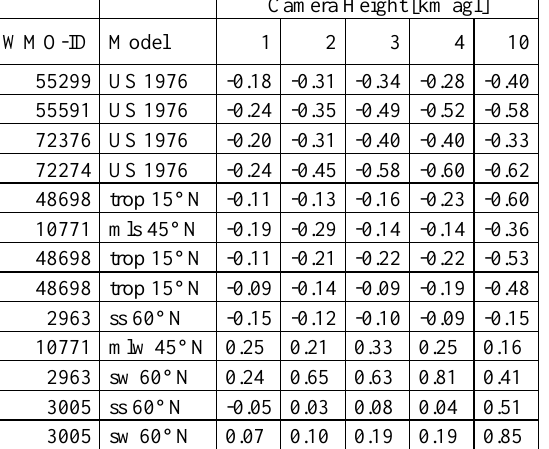
Table 5. Difference of the radial image height displacement [um] between Eqn (5) and Eqn (9) for different camera height and for all sites for a camera with a view angle of ±38° and a focal length of 62.7 mm.